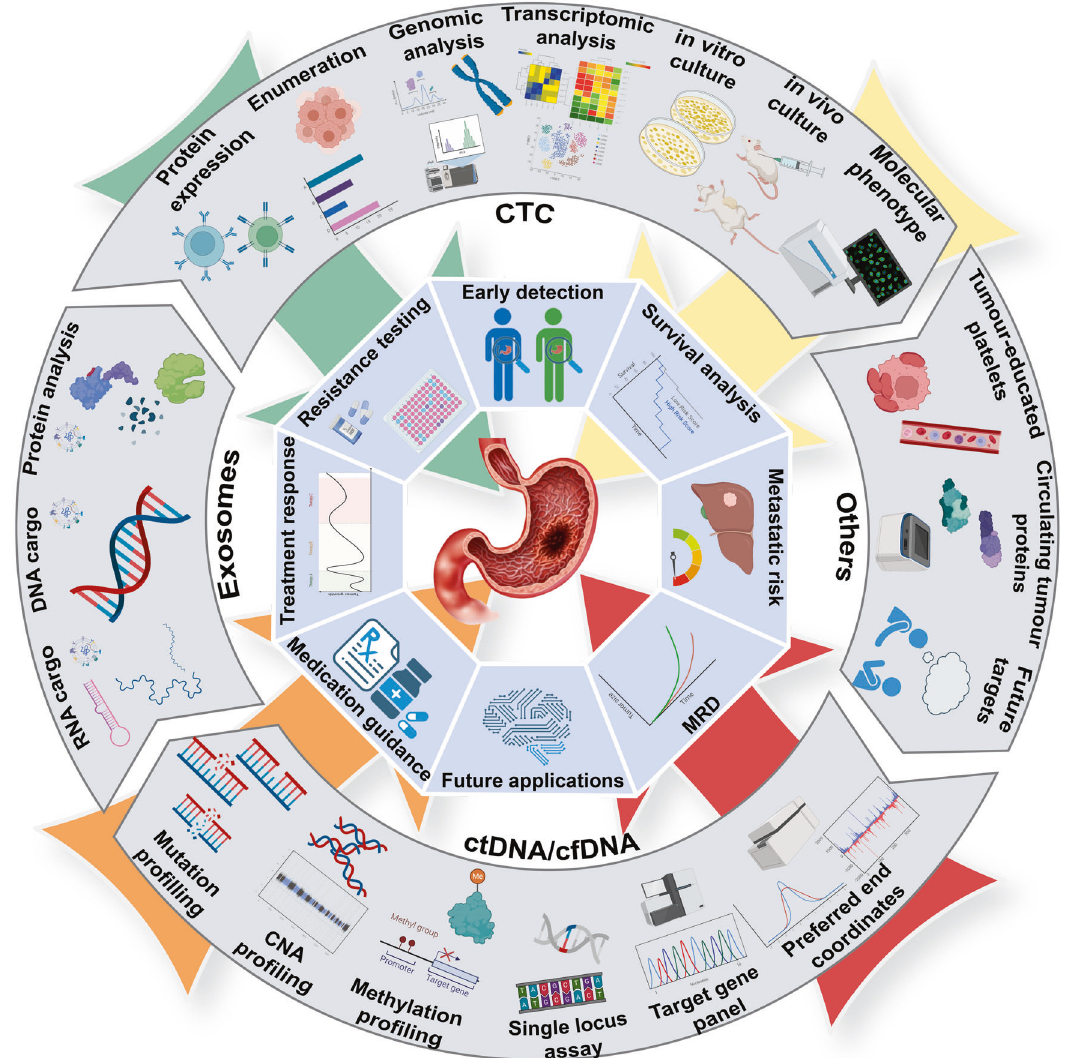
Fig. 4 Overview of characteristics and clinical applications of liquid biopsy in gastric cancer. Liquid biopsy is regarded as an important tool in the future, as it could achieve multiple goals, such as early detection, medication guidance, treatment monitoring, resistance testing, minimal residual disease (MRD) detection, survival analysis and metastatic prediction. CTCs and ctDNA/cfDNA are primary targets of liquid biopsy, while other targets are being explored, for example, exosomes containing proteins or DNA and RNA fragments, tumor-educated platelets and circulating tumor proteins. Methods like mutation pro fi ling, CNA pro fi ling, methylation pro fi ling and preferred end coordinates detections are used to acquire qualitative and quantitative information of ctDNA. Assays for single locus and multiple target gene panel are being developed. CTCs provide DNA, RNA protein expression and molecular phenotype at single cell level and can be cultured in vivo or in vitro for further